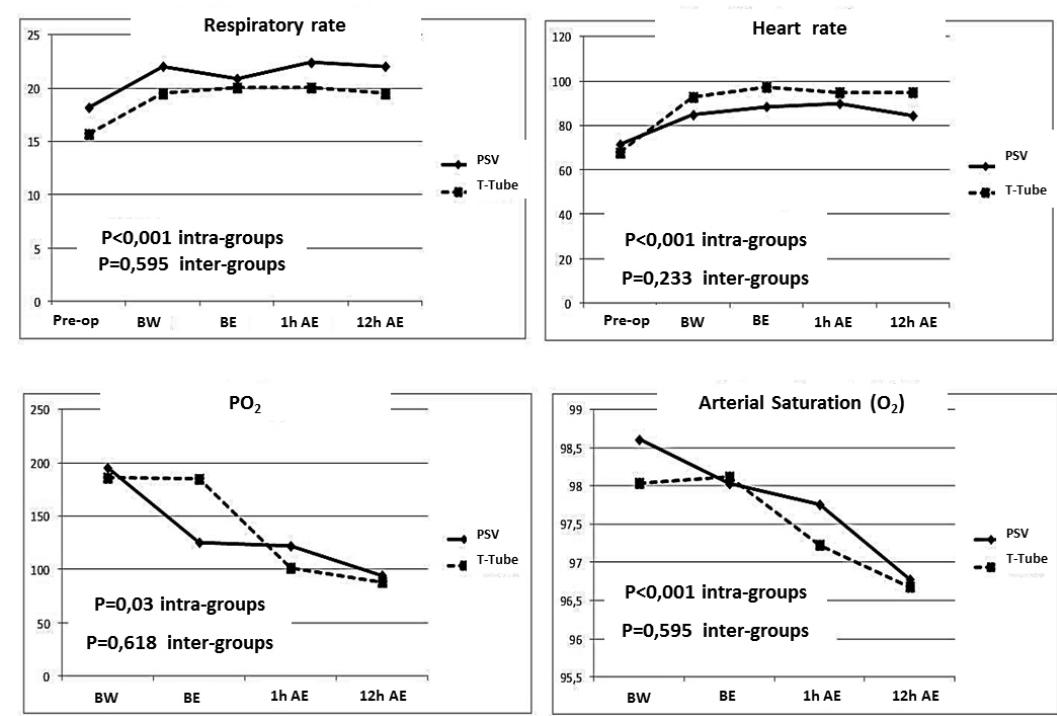
Fig. 3 - Perioperative evolution of the respiratory rate, heart rate, PO preoperative; BW: before weaning; BE: before; 1h AE: 1 hour after extubation; 12h AE: 12 h after